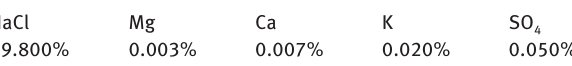
Table 1: Chemical composition of sodium chloride NaCl Mg Ca K SO 4